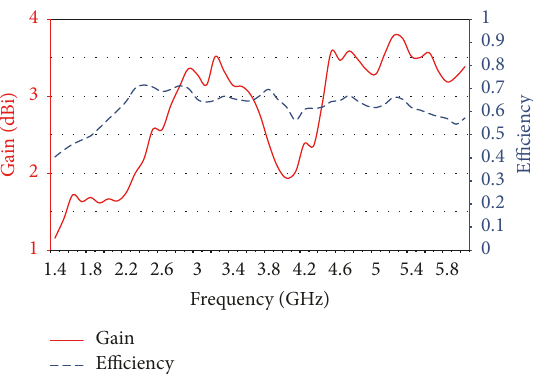
Bluetooth, satellite navigation system, WLAN, and WiMAX applications. The multiband antenna covers three